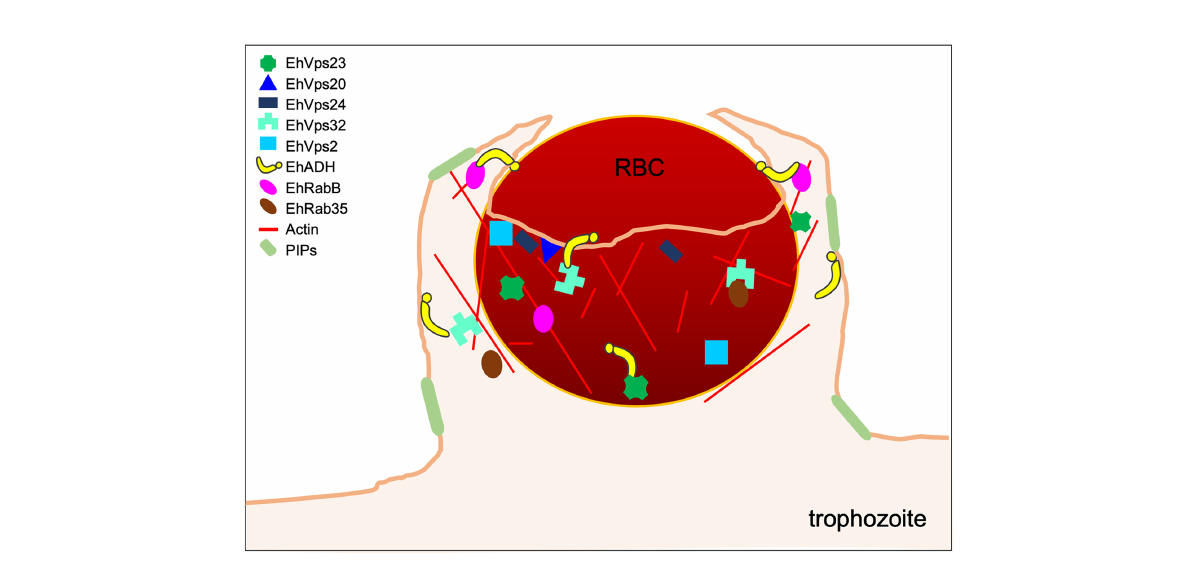
FIGURE 2 Phagocytic cup formation. During RBCs internalization, the PM deformation involves the actin cytoskeleton and some small GTPases, as EhRab35, to generate the phagocytic cup. Other molecules have been localized in these structures, such as lipids (PIPs), EhRabB, and ESCRT-I, ESCRT-III and ESCRT accessory